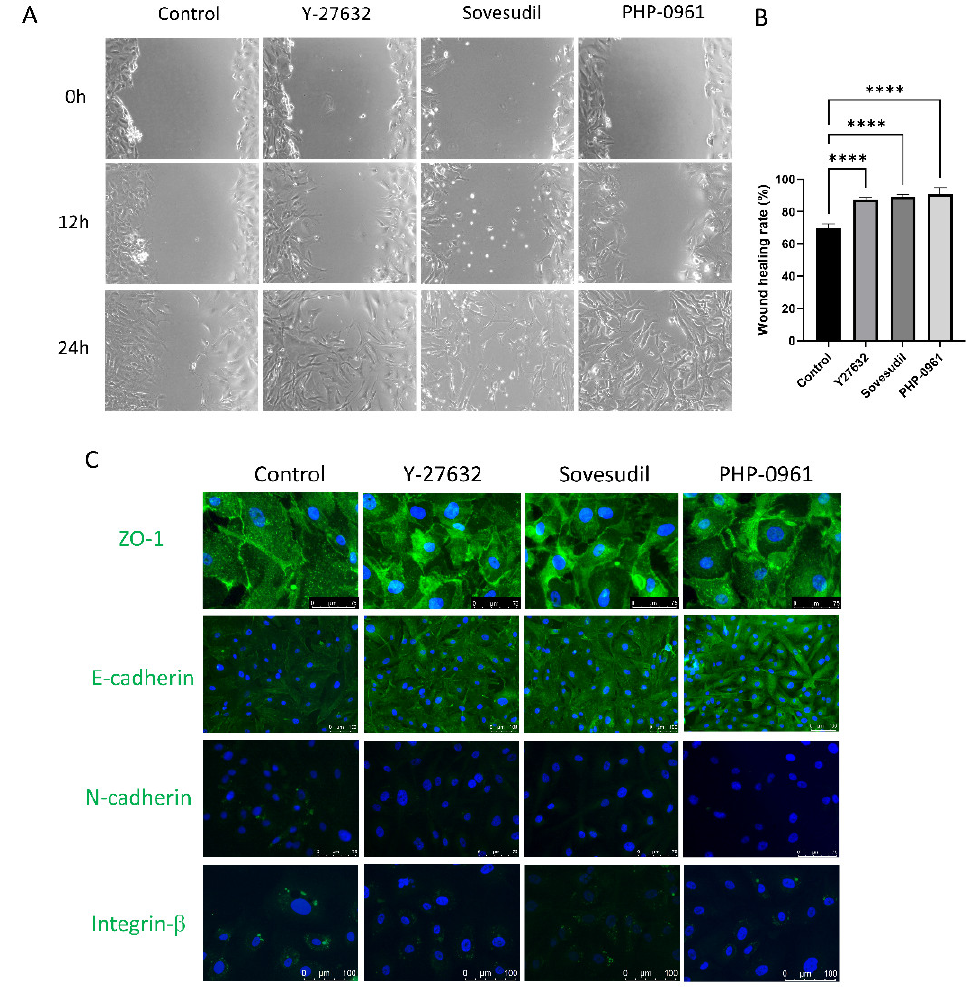
Figure 2. Cell migration and cell adhesion molecules. ( A , B ) A cell scratch assay was performed to evaluate the effect of ROCK inhibitors on wound healing rate. ( C ) Cell adhesion molecules were evaluated by immunofluorescence staining for ZO-1, E-cadherin, N-cadherin and integrin β1. **** p < 0.0001.